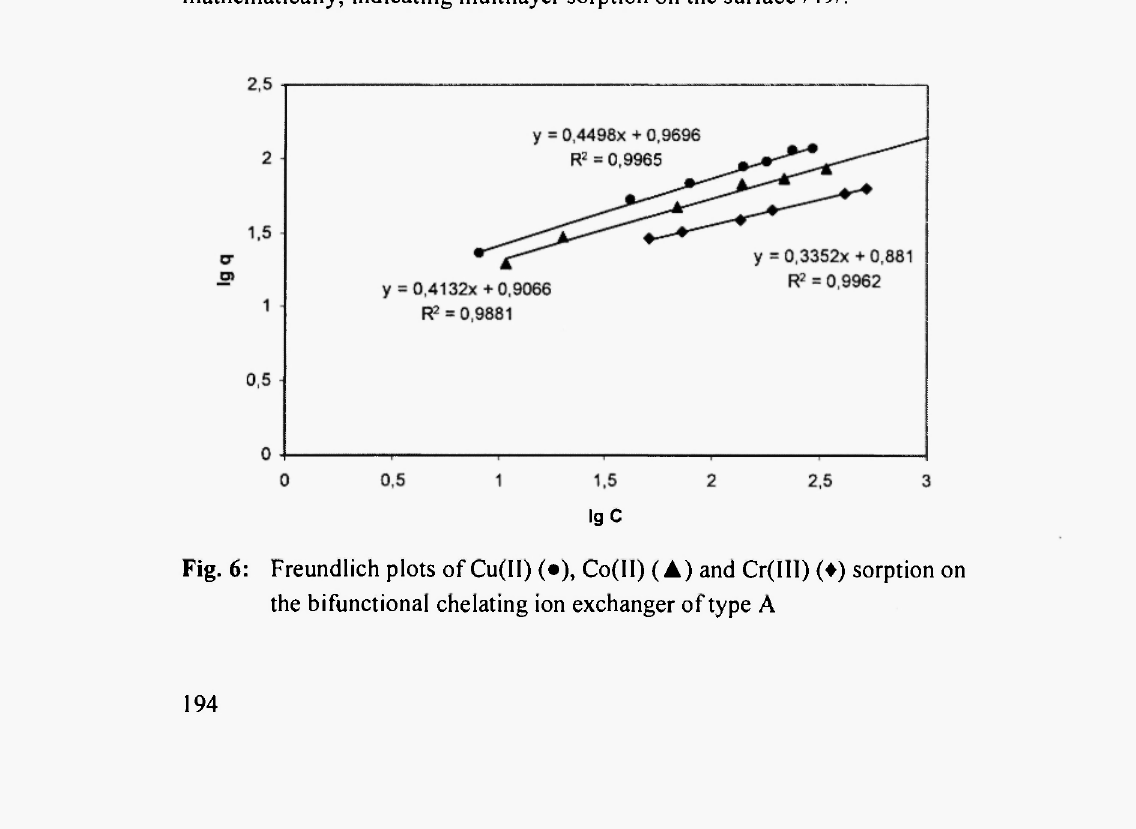
Fig. 6: Freundlich plots ofCu (II) ( · ), Co (II) ( A) and Cr (III) (•) sorption on the bifunctional chelating ion exchanger of type A